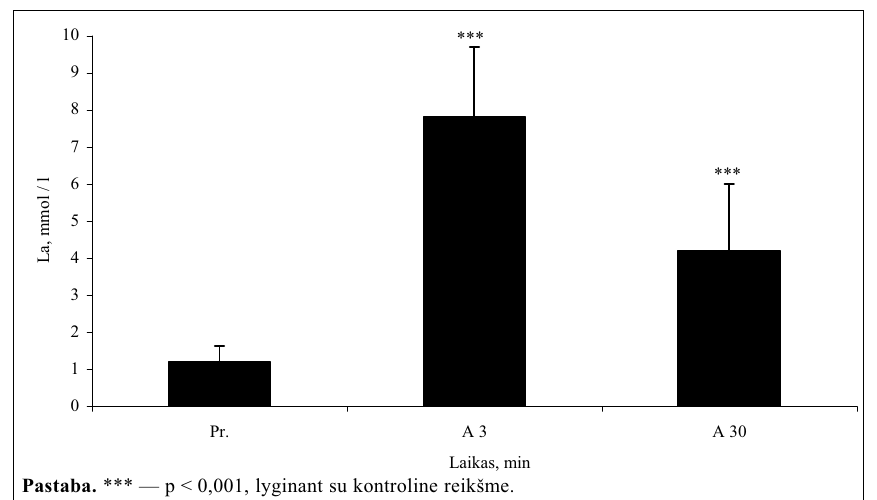
jėgų (P 20 / P 50), sukeltų mažo (P 20) ir didelio (P 50) dažnio elektros impulsų, po krūvio praėjus 3 ir 30 minučių, santykio reikšmės sumažėjo reikšmingai (p < 0,001) (3